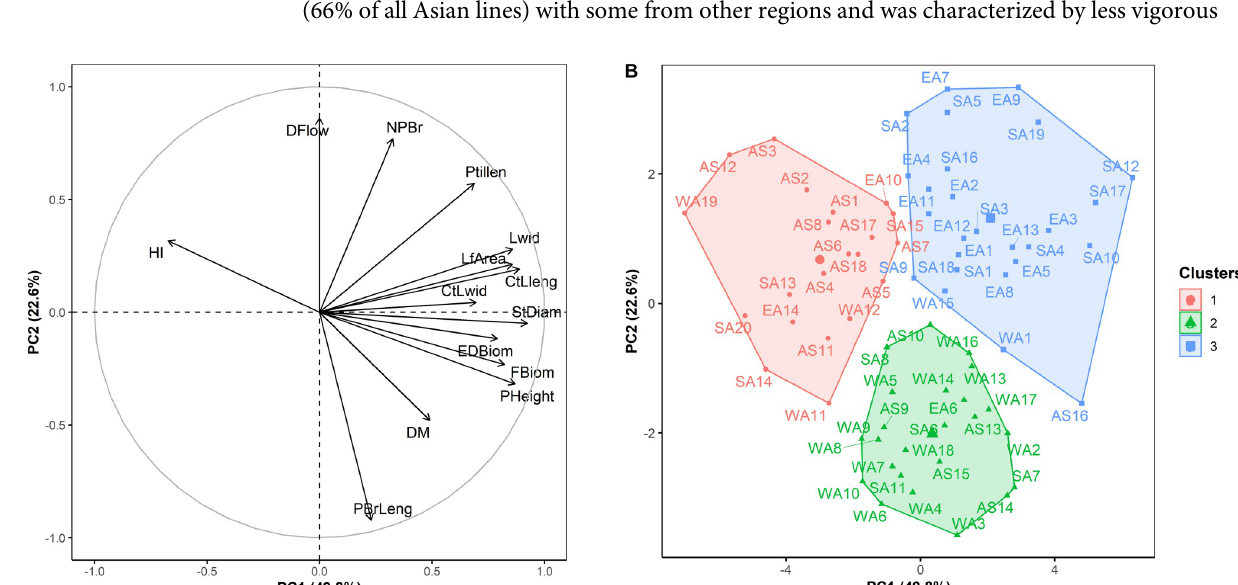
Fig 2. Plots of Pearson’s phenotypic (A) and genotypic (B) correlation coefficients for fourteen agronomic traits of 71 advanced lines of Gynandropsis gynandra . StDiam: Stem diameter (mm), PHeight: Plant height (cm), PBrLeng: Primary branch length (cm), NPBr: Number of primary branches, CtLleng: Central leaflet length (cm), CtLwid: Central leaflet width (cm), Lwid: Leaf width (cm), Ptillen: Petiole length (cm), LfArea: Leaf area (cm 2 ), FBiom: Total